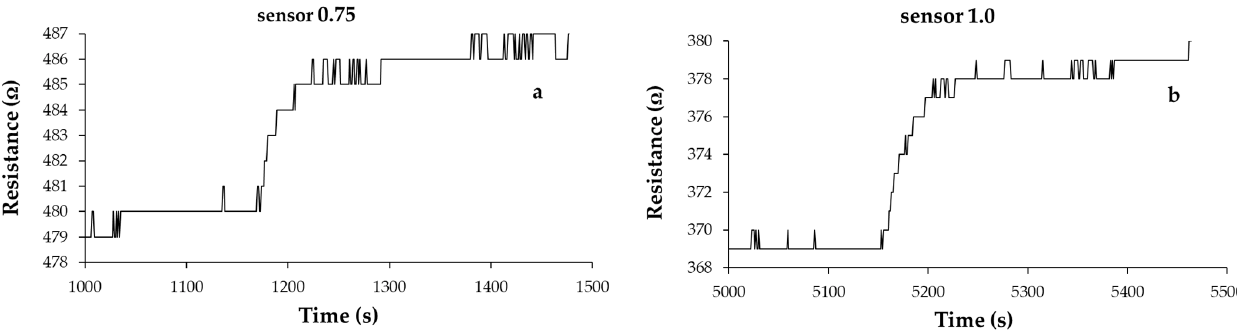
Figure 11. Response time of the RH resistive at room temperature for 40% RH–50% RH step: ( a ) sensor 0.75 and ( b ) sensor 1.0.